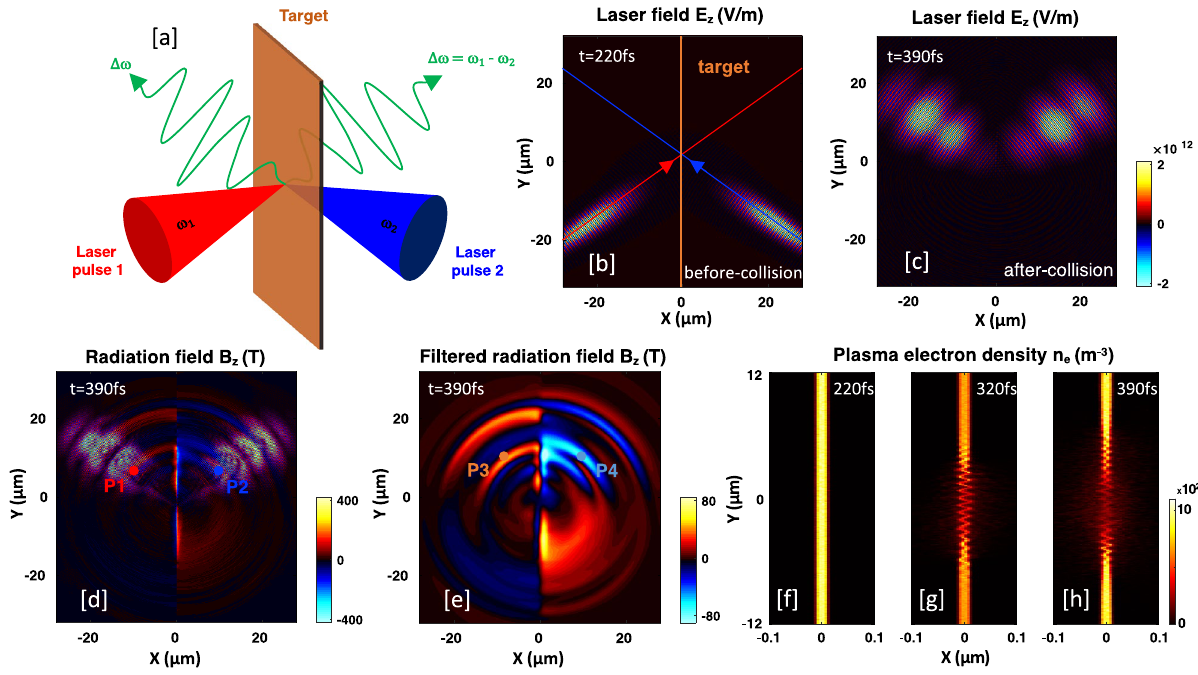
Figure 1. ( a ) Sketch of the scheme: Two laser pulses with different frequencies, ω 1 and ω 2 collide obliquely with each other on an overdense plasma sheet of nm thickness. From the region of the colliding laser pulses, beat- ω 1 ω 2 ) is emitted into the vacuum. Snapshots of spatial distributions of; ( b , c ) frequency radiation (�ω = − laser field E z ( V / m ) (s-polarized), ( d ) total radiation field B z ( T ) (p-polarized), ( e ) filtered radiation field B z ( T ), 220 fs , 320 fs , and 390 fs and ( f – h ) plasma electron number density n e ( m − 3 ) , at different times; t =